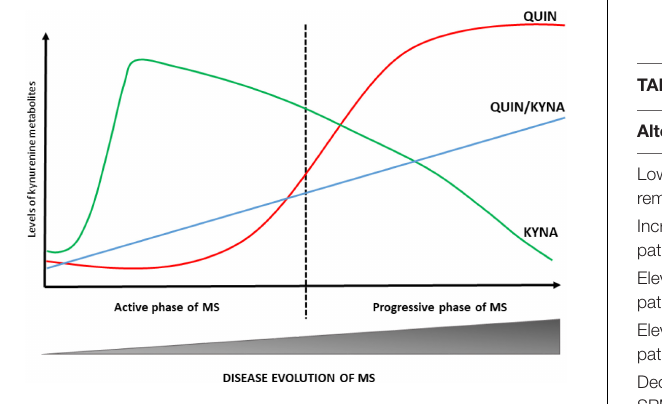
FIGURE 2 | Changes in KP profile during disease course of MS. The KP metabolic profile changes at different stages of MS. In the active phase of MS, the KYNA levels are increased. During the progressive phase of the disease QUIN levels and QUIN/KYNA ratio are increased. These changes in metabolic profile of the KP have a strong association with disease activity. KYNA, kynurenic acid; MS, multiple sclerosis; QUIN, quinolinic acid.